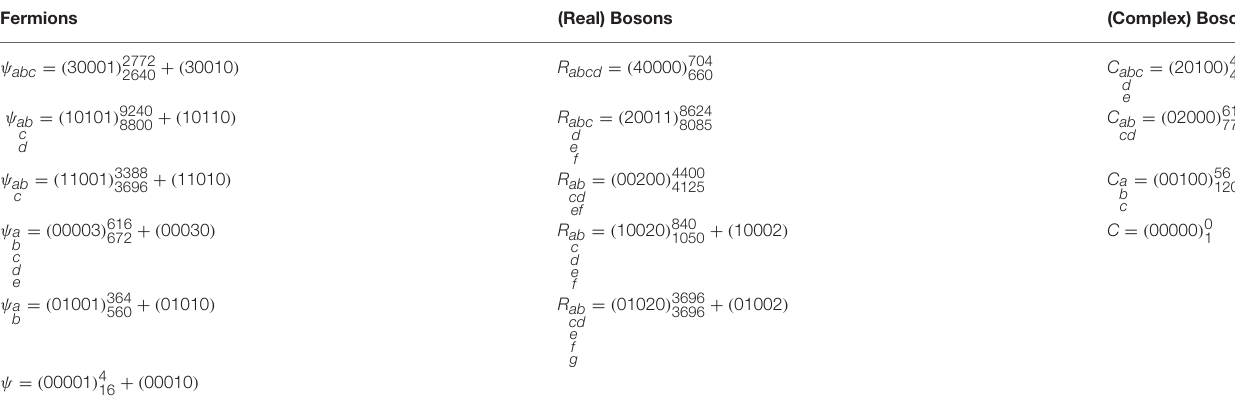
TABLE 1 | D = 12 Local fields and their massless 0(10) on-shell states. Fermions (Real) Bosons (Complex) Bosons